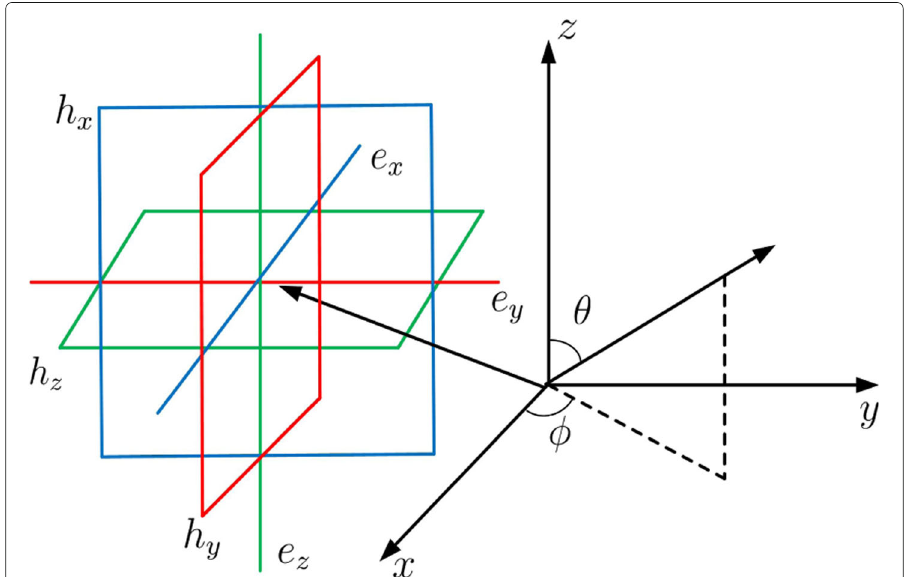
Fig. 1 Diagram of a six-component